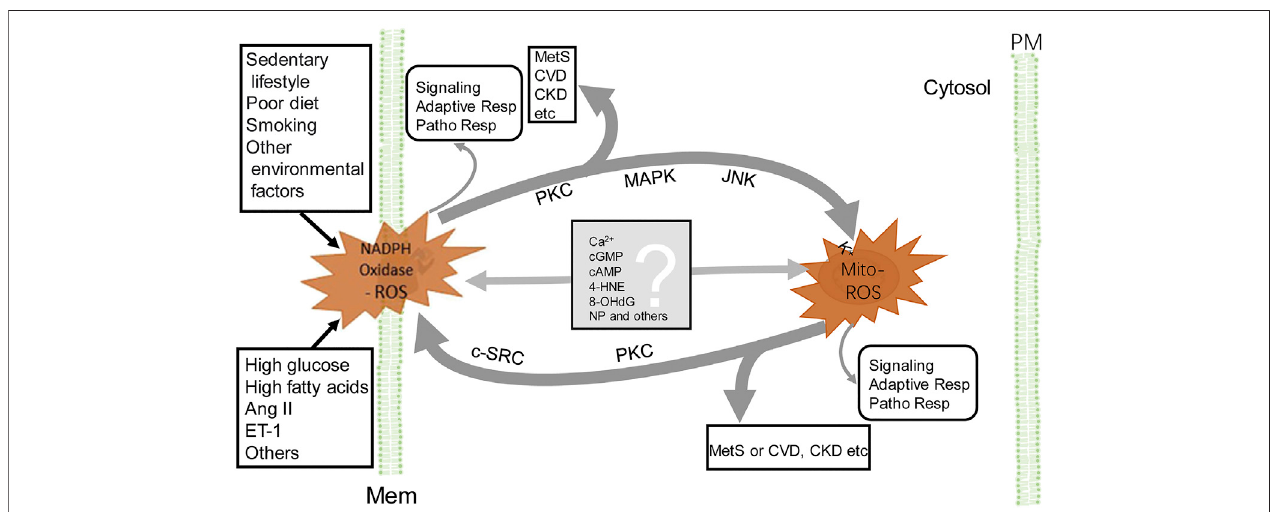
FIGURE 2 | Crosstalk between NADPH oxidase and mitochondria-derived ROS. NADPH oxidase activation, by endogenous and exogenous stimulation (for exampleAngII),producesROS,whichstimulatePKC,MAPK,andJNK,leadingtotheincreaseinMito-ROSproduction(seethetext).ROS,releasedfrommitochondria, activate redox-sensitive PKC and c-SRC, which phosphorylate NADPH oxidases and increase ROS production by NADPH oxidases. The Mito-ROS trigger NADPH oxidases activation and generation of ROS and vice versa, resulting in a vicious circle (thick gray lines). The converged increase in ROS contributes to the pathogenesis of MetS, CVD, and CKD, among others. In addition to PKC, other potential molecules (listed in the gray box) relay the signaling between NADPH oxidase and mitochondria. ROS generated by either NADPH oxidase or mitochondria exert their individual actions, such as signaling, adaptive responses, and pathophysiological responses (very thin gray line arrows). 4-HNE, 4-hydroxynonenal; 8-OHdG, 8-hydroxy-20-deoxyguanosine; Adaptive Resp, adaptive responses; CKD, chronic kidney disease; c-SRC, proto-oncogene tyrosine-protein kinase; CVD, cardiovascular disease; MAPK, mitogen-activated protein kinase; PM, plasma membrane and other cellular membranes (Mem), such as in endoplasmic reticula, endosomes etc; MetS, metabolic syndrome; Mito-ROS, ROS generated from mitochondria (right side); NADPH Oxidase-ROS, ROS generated from NADPH oxidases (left side); NP, nanoparticles or microparticles; Patho Resp, pathological responses; PKC, protein kinase C. For simplicity, other ROS-generating sources and enzymatic and non-enzymatic antioxidants are not